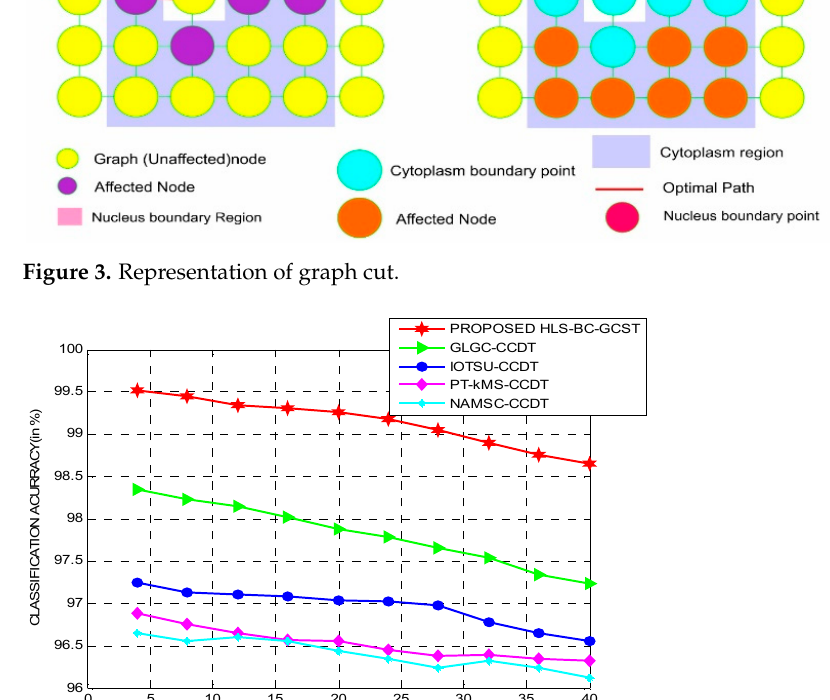
Figure 4. Comparative performance of the proposed HLC-BC-GCST scheme (using classification accuracy).